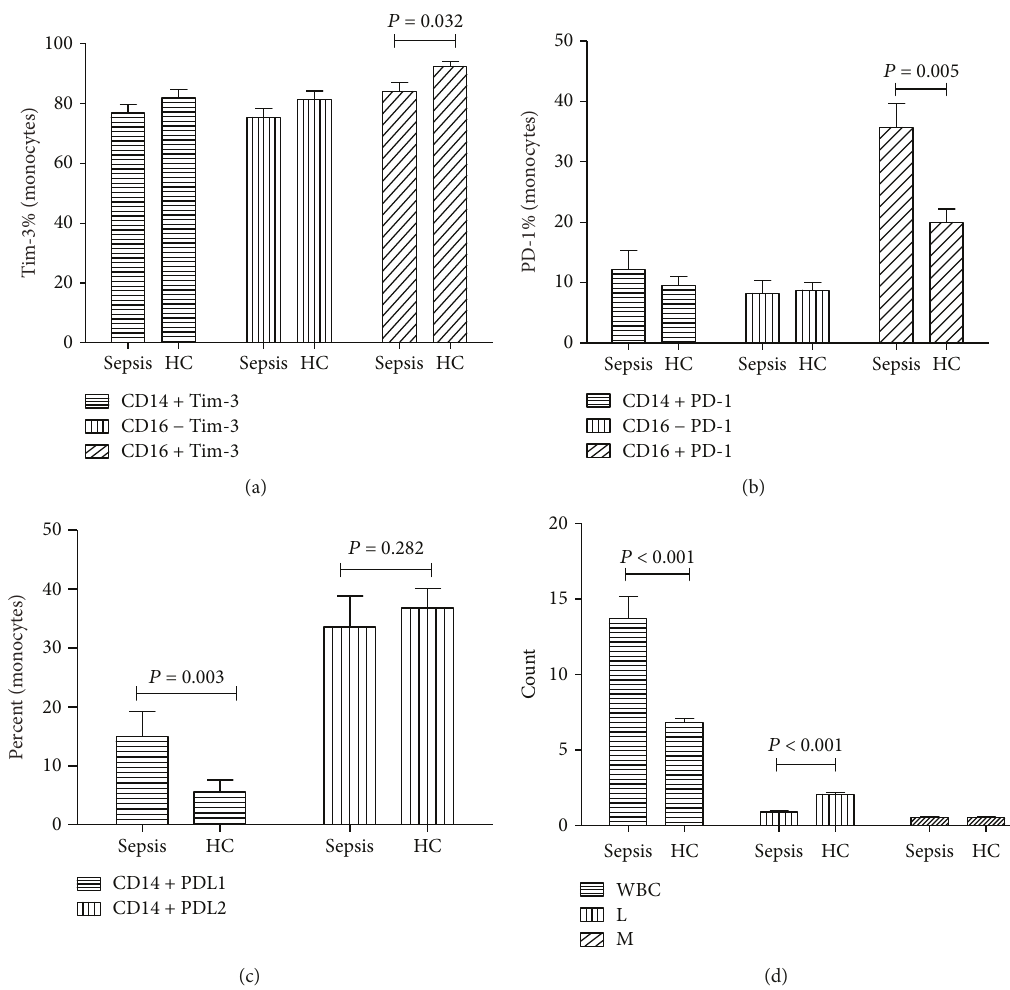
Figure 2: (a) The percentages of CD14+Tim-3+, CD14+CD16 − Tim-3+, and CD14+CD16+Tim-3+ on monocytes. (b) The percentages of CD14+PD-1+, CD14+CD16 − PD-1+, and CD14+CD16+PD-1+ on monocytes. (c) Percentage of PDL1 and PDL2 on monocytes. (d) Count of white blood cells, lymphocytes, and monocytes. Statistical analysis was performed by the Mann – Whitney